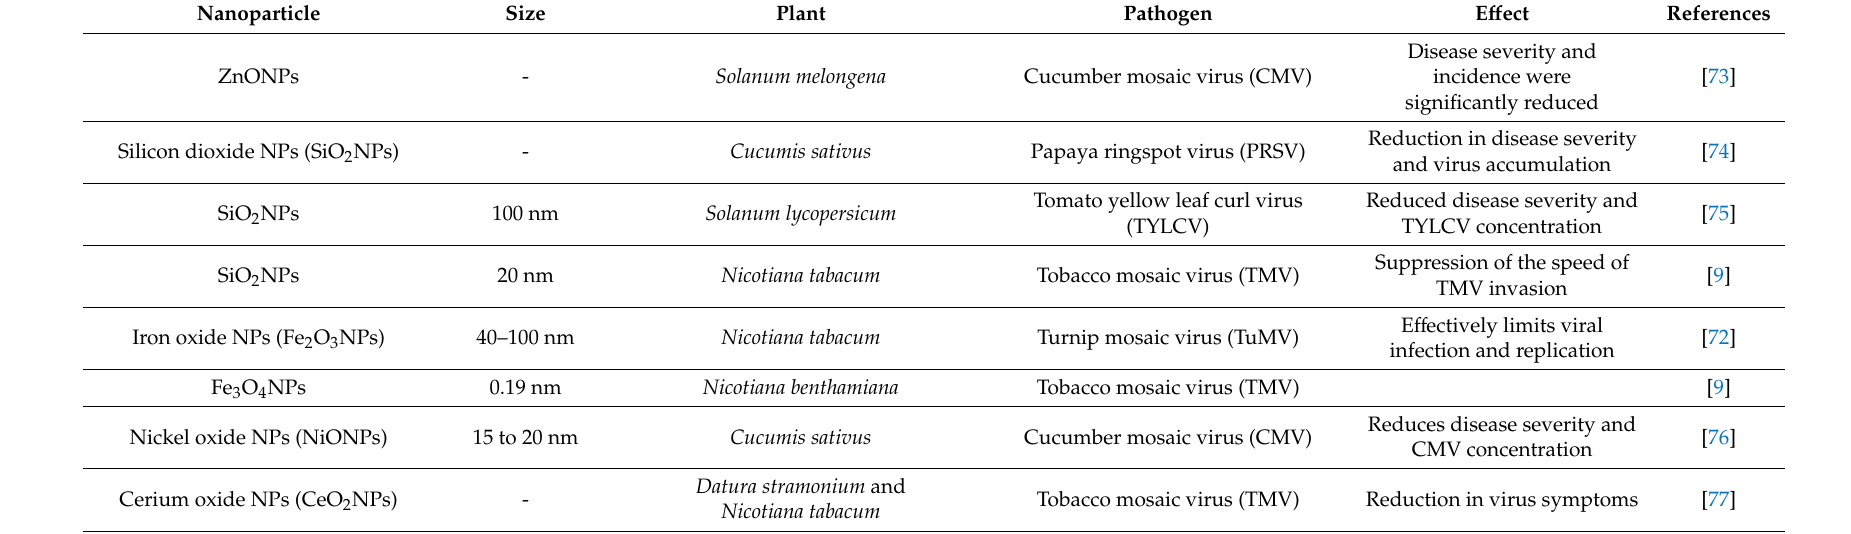
Table 1. Antiviral activity of metal and metal and metal oxide